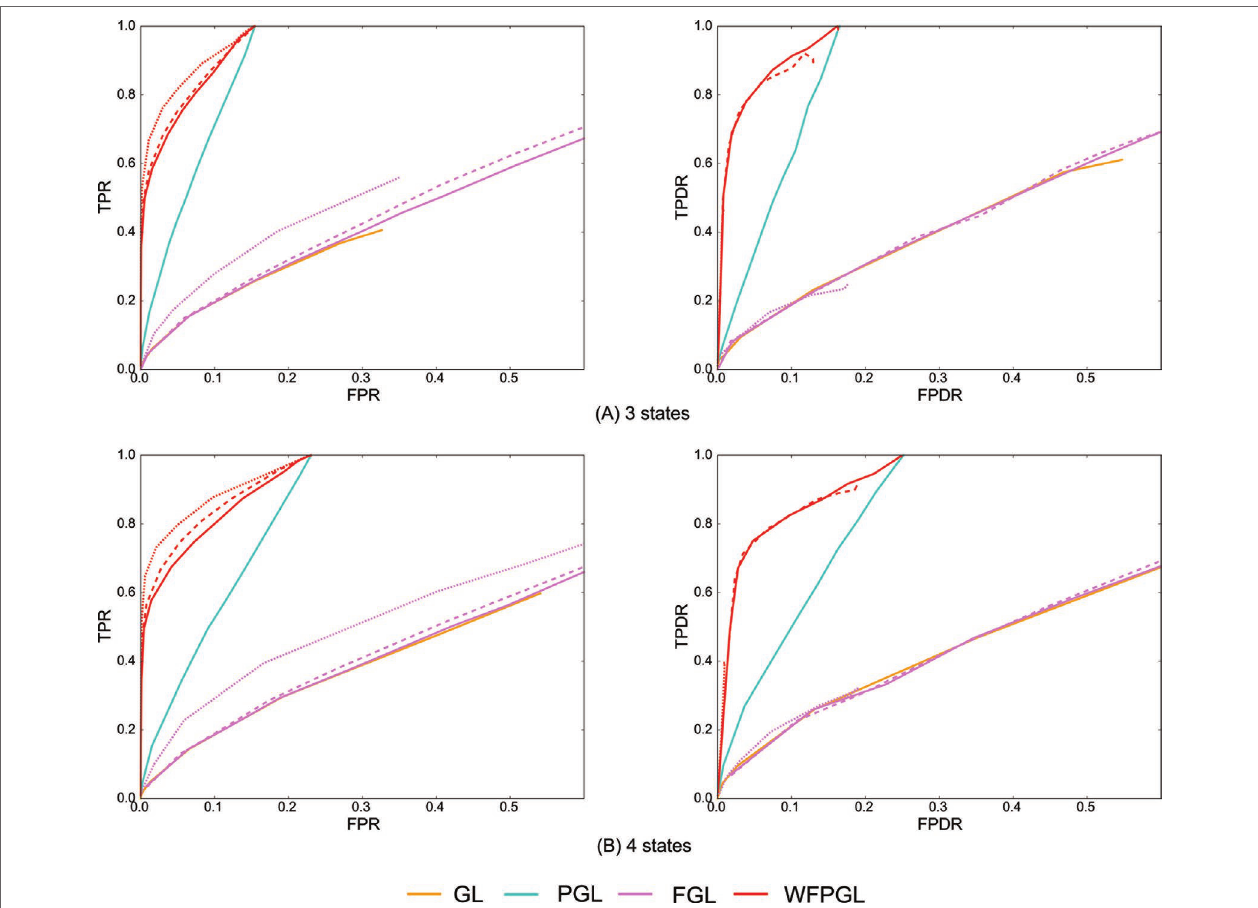
FIGURE 3 | The experiment results of various methods on multiple groups of samples: (A) Dataset 1 for three states. (B) Dataset 2 for four states. The performance of various methods on individual network estimation (with respect to TPR and FPR) is shown on the left side, while the performance of various methods on differential network estimation (with respect to TPDR and FPDR) is shown on the right side. For WFPGL and FGL, different line styles corresponding to different choices of λ 2 : solid line for λ 2 = 0.0001, dashed line for λ 2 = 0.001, and dotted line for λ 2 =